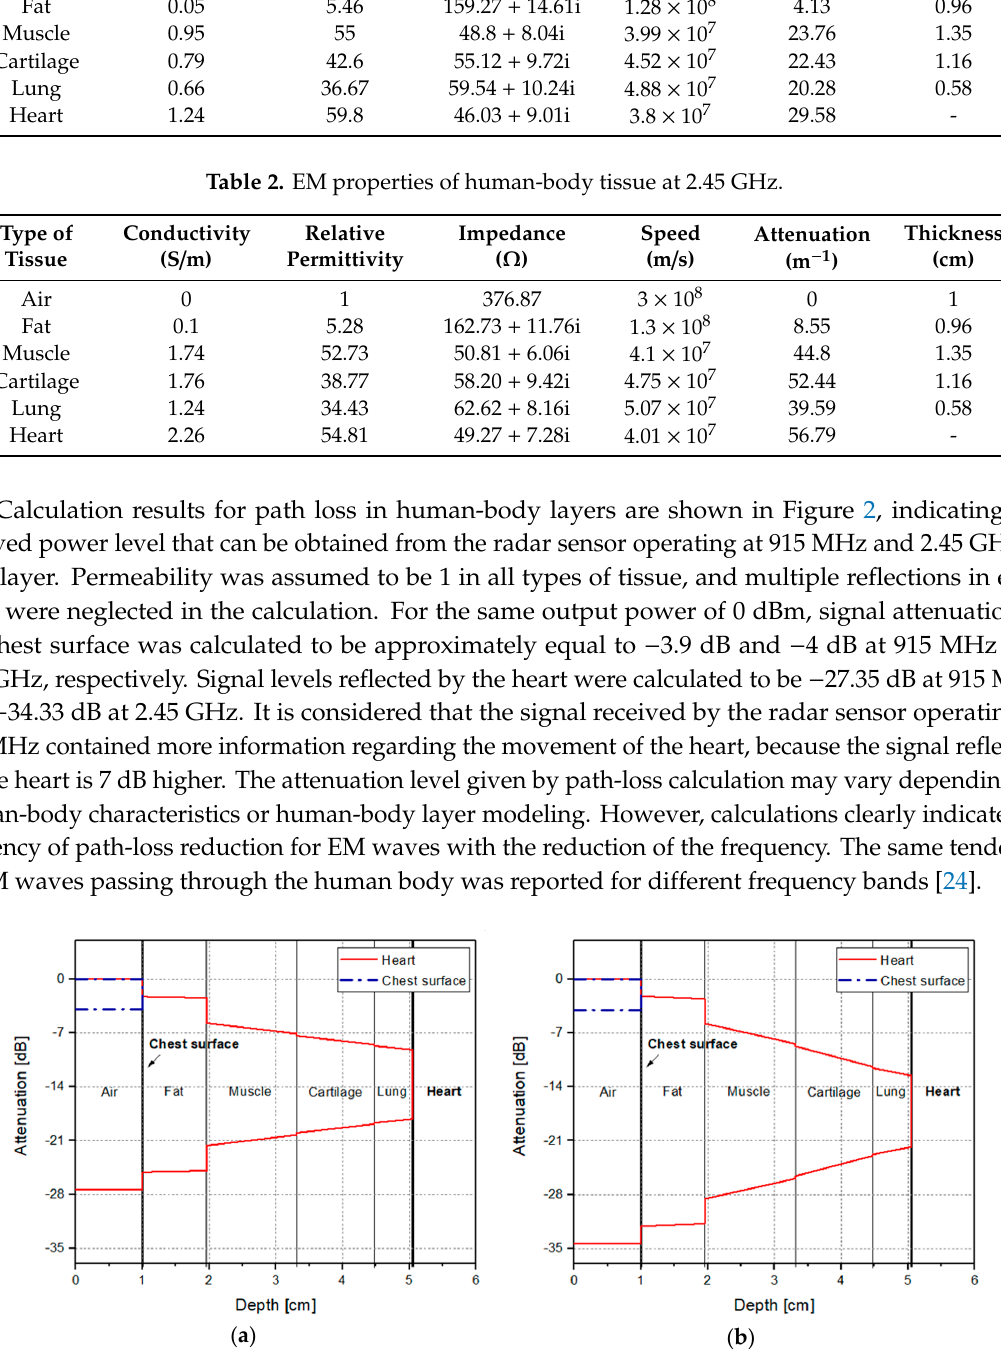
Table 1. Electromagnetic (EM) properties of human-body tissue at 915 MHz.